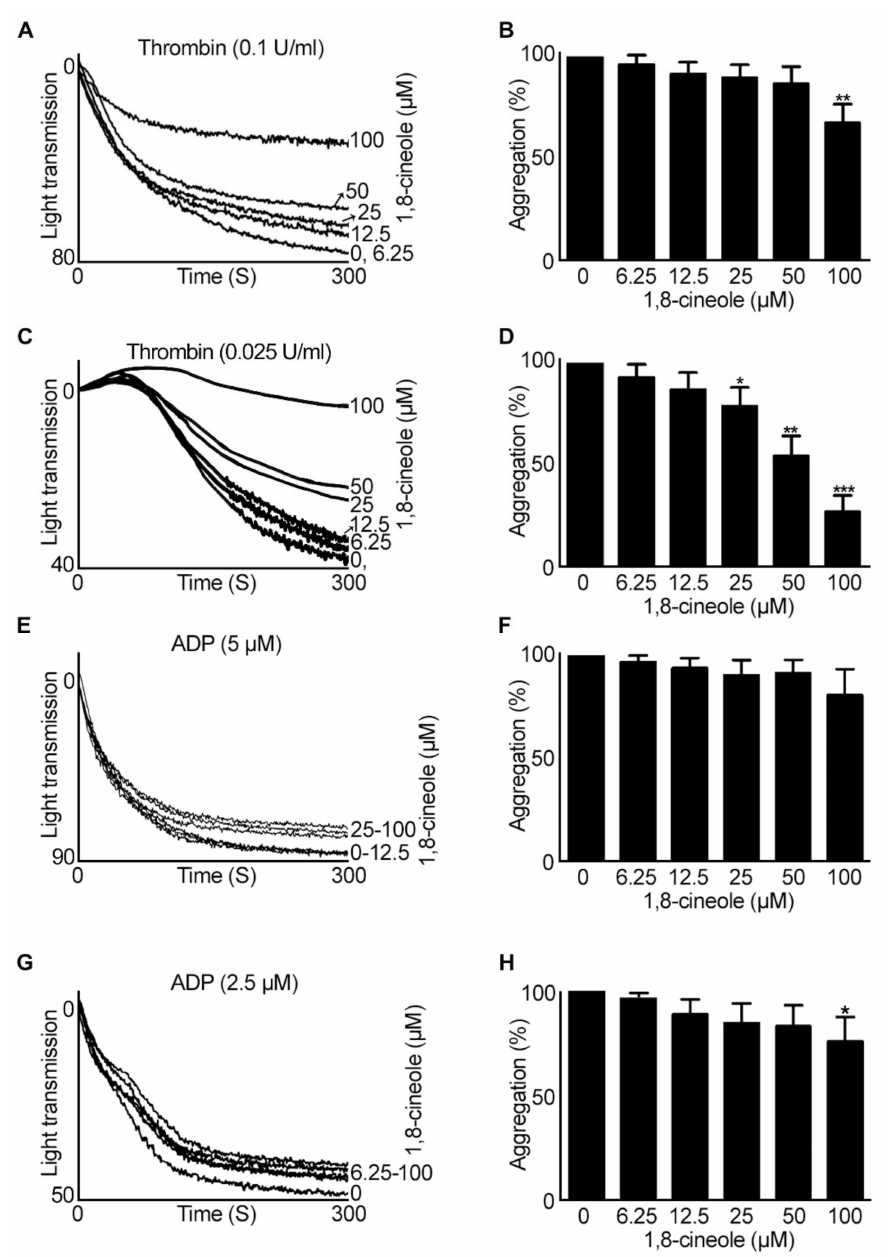
Figure 3. Effect of 1,8-cineole on thrombin- and ADP-stimulated aggregation in human